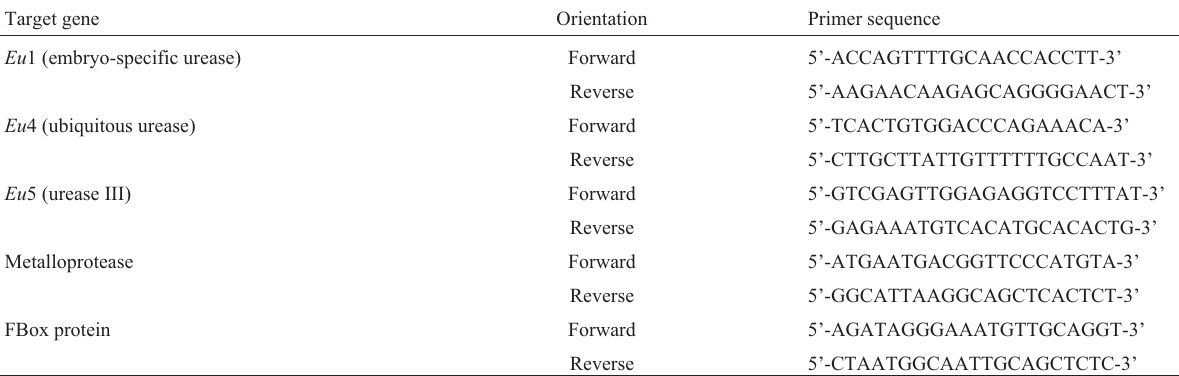
Table 1 - Primer set designed for RT-qPCR. Target